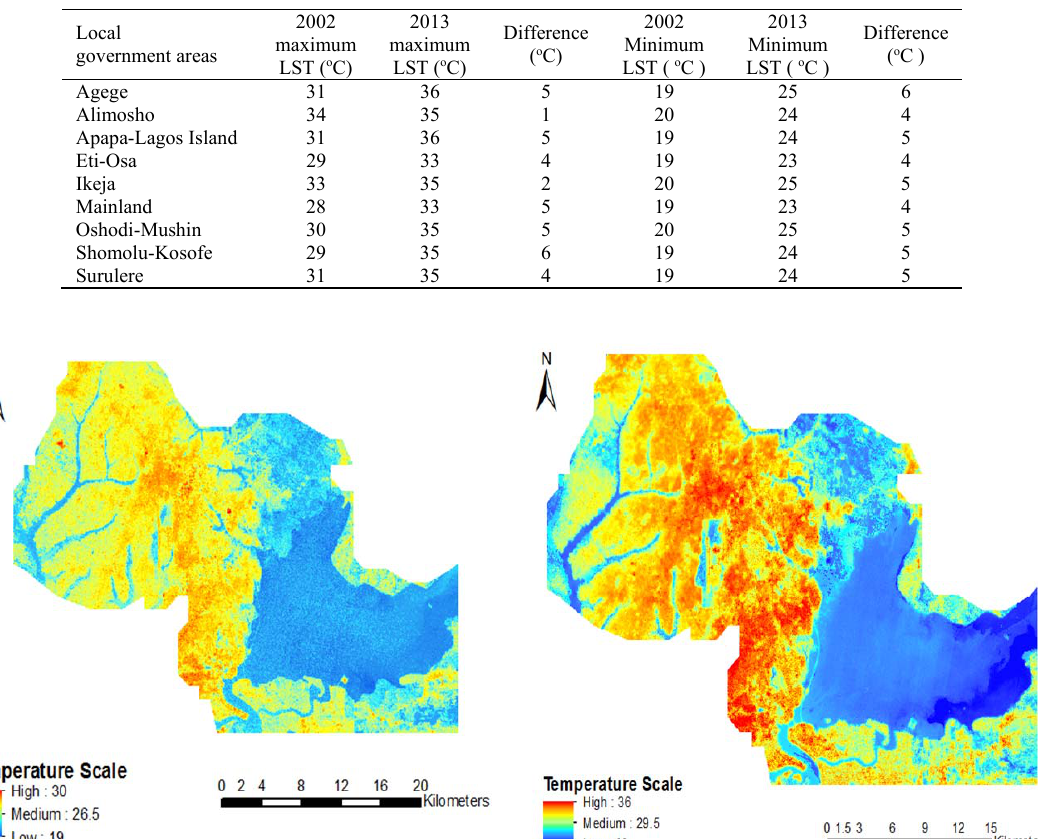
Table 3: The maximum and minimum land surface temperature for each local government area (2002 and 2013)